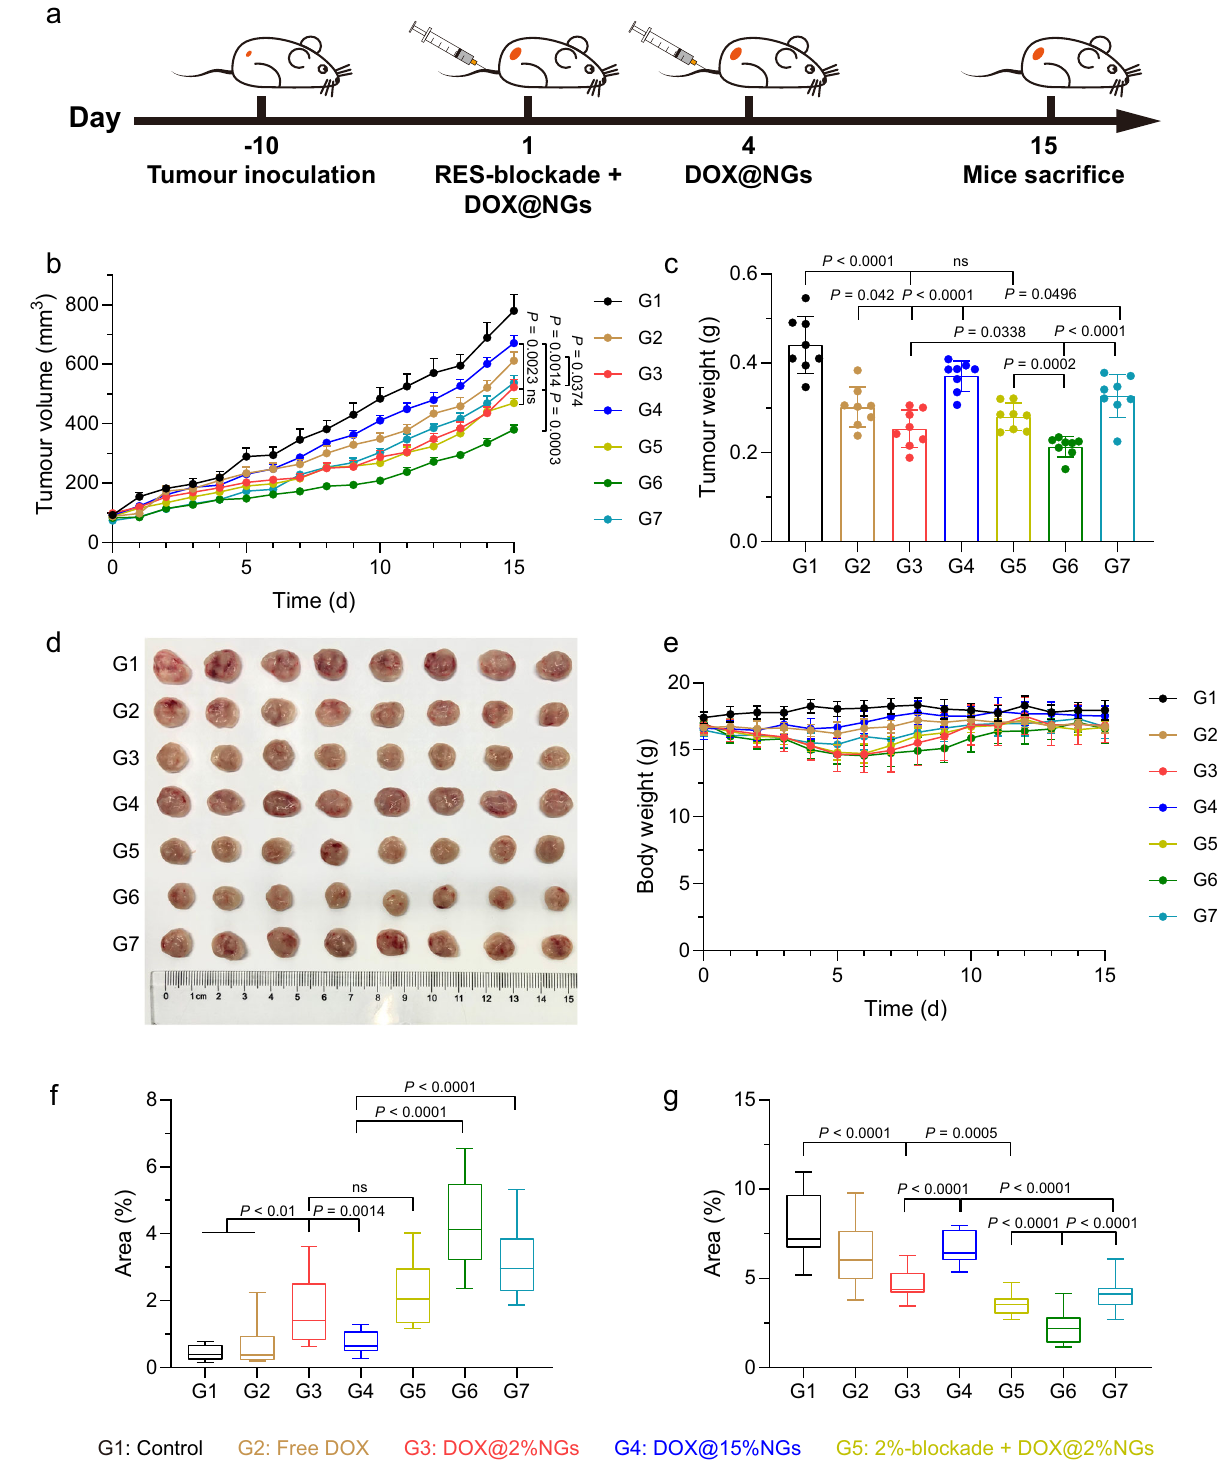
Fig. 6 | Stiff-blockade combined with soft delivery contributing to enhanced antitumour ef fi cacy. a Illustration of drug administration strategy. b Tumor growthpro fi lesof4T1tumor-bearingmicetreatedbydifferentcombinationofRES- blockade and drug delivery strategy at RES-blockade dosage of 200mg/kg and DOX dosageof 4mg/kg. Data are presented asmeanvalues±SEM ( n =8 biological independentreplicates). c Weightoftumorsaftertreatment.Dataarepresentedas meanvalues±SD( n =8biologicalindependentreplicates). d Photographoftumors extracted from the mice after treatment. e Body weight pro fi les of mice after